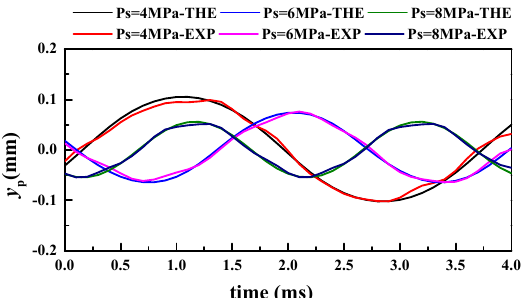
MSE tri. = 2.71 × 10 − 4 ). Energies 2018 , 11 , x FOR PEER REVIEW MSE tri. = 2.71 × 10 −4 ).